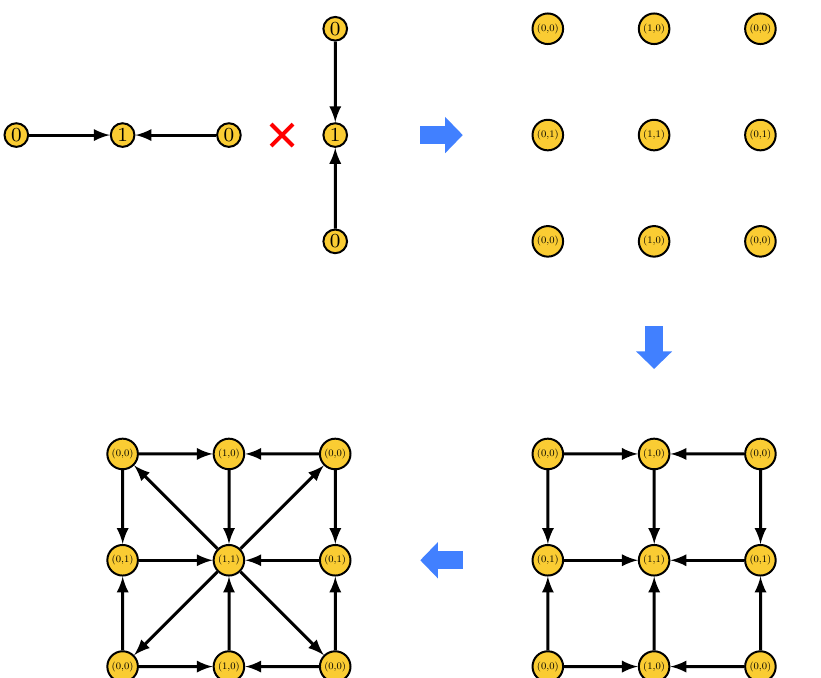
Figure 7. A product of periodic quivers resulting in phase 2 of F 0